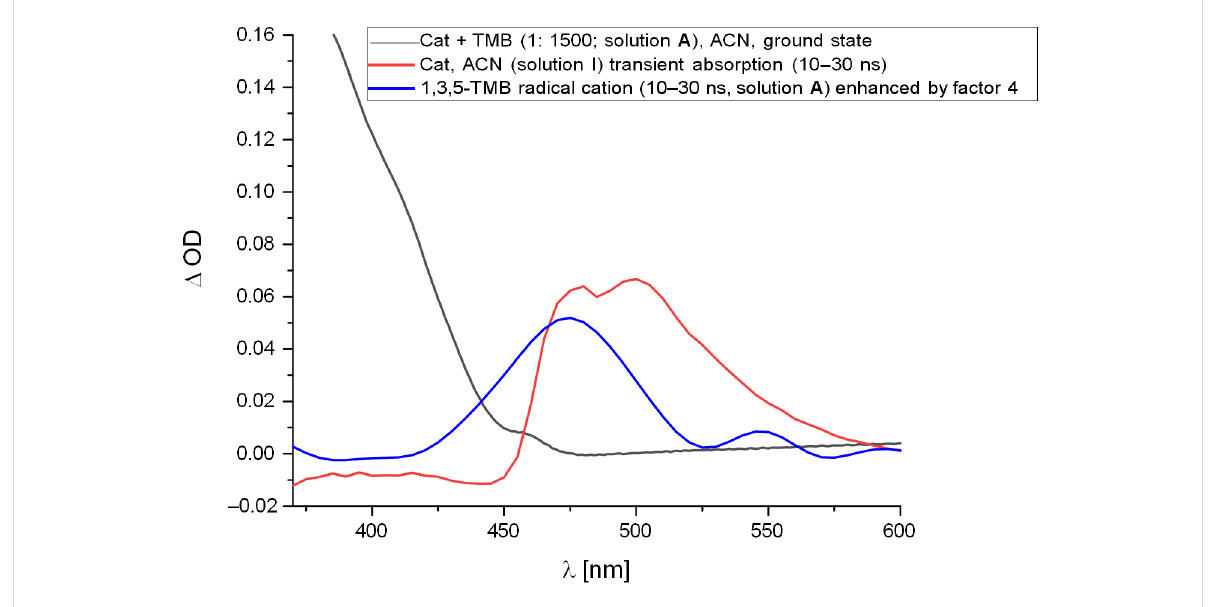
Figure 4: Black line: UV–vis spectrum of the degassed [Ir] + 1,3,5-TMB mixture (solution A ) in ACN. Blue and red lines: Absorption spectra averaged over 10–30 ns after 355 nm laser-pulse with red being derived from the [Ir] solution I and representing the emission spectrum of the catalyst. Where- as, the blue line was obtained from the difference spectrum [Ir] and [Ir] + TMB and represents the transient absorption spectrum of 1,3,5-TMB •+ with λ max of 473 nm (solution A